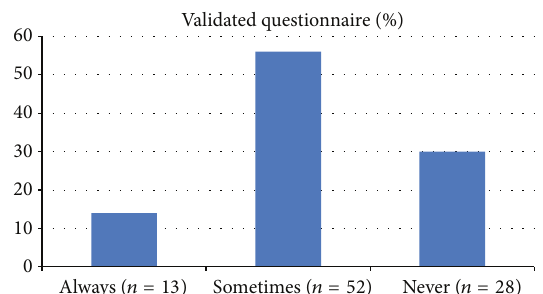
Figure 1: Application rates of the questionnaire with validated symptom scoring system.